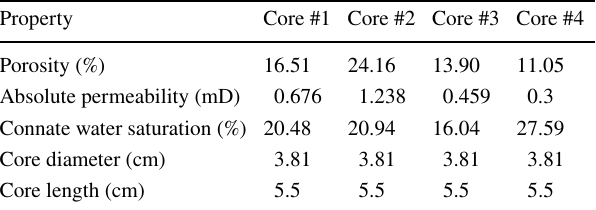
Table 1 Rock properties and core dimensions used in the experiments Property